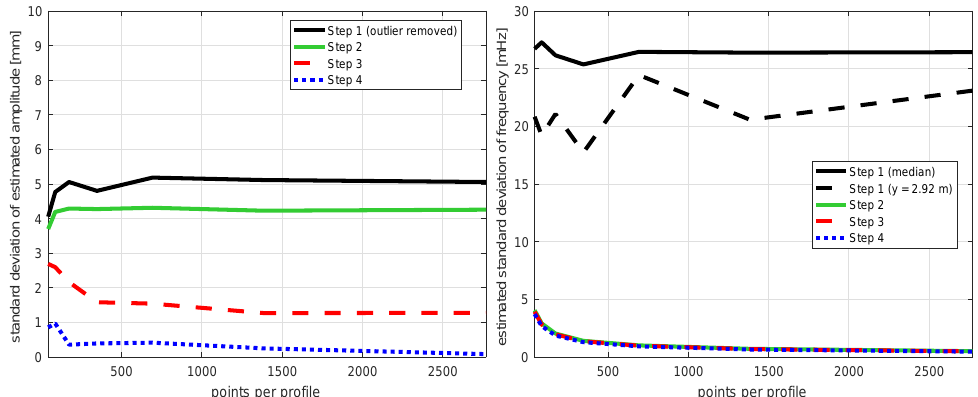
Figure 9. Results of set-up “point distance”: standard deviation of amplitude ( left ) and frequency ( right ). For reasons of clarity, the vertical axes are limited to 10 mm or 30 mHz,